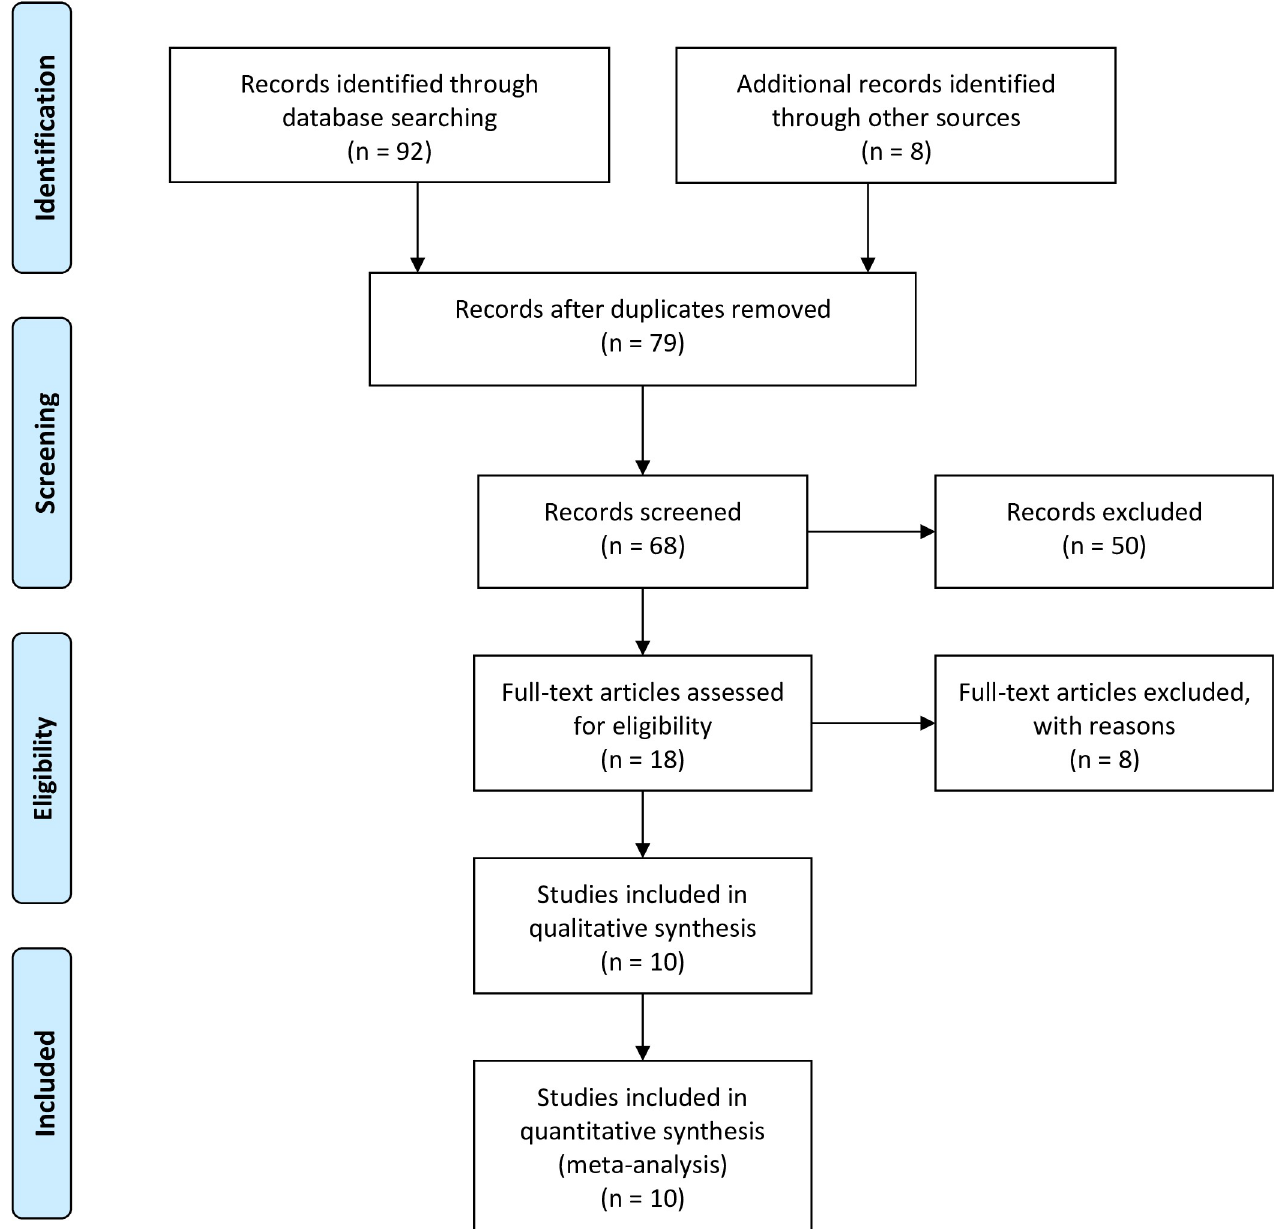
Fig 1. Flow diagram of data sources, screening, and